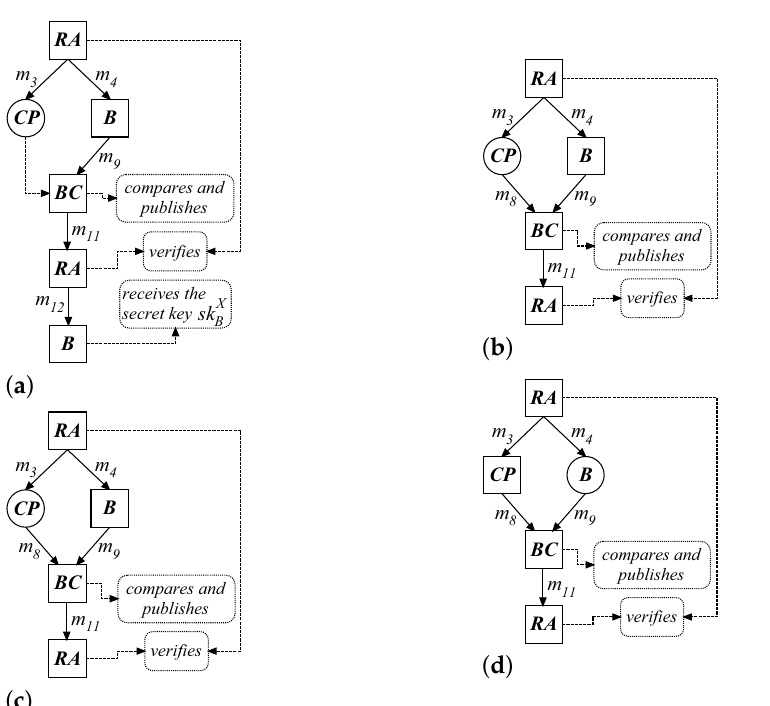
Figure 1. The paths of pk X B ( a ), E path of all tokens when B is corrupt ( d